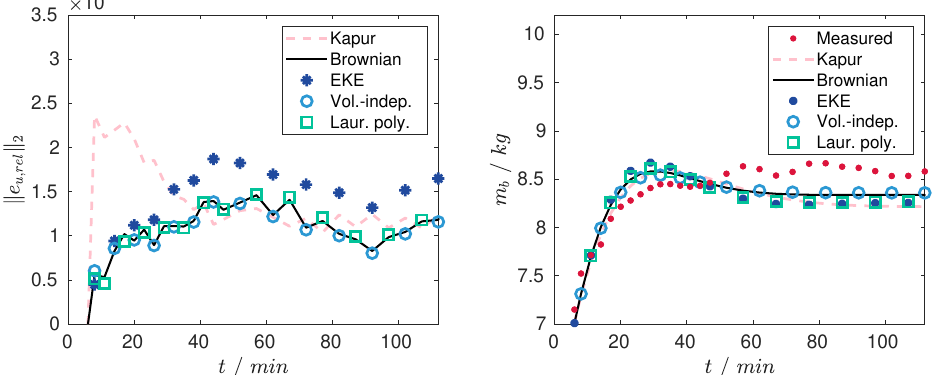
Figure 5. Comparison of the L 2 norms of the PSD error ( Left ) and the actual bed mass and bed masses of the identified models ( Right ) for the shifted time domain.